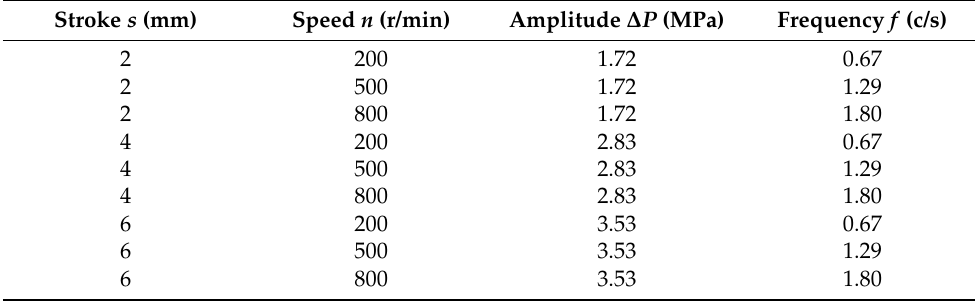
Table 3. Pulsation parameters of the amplitude and frequency in the